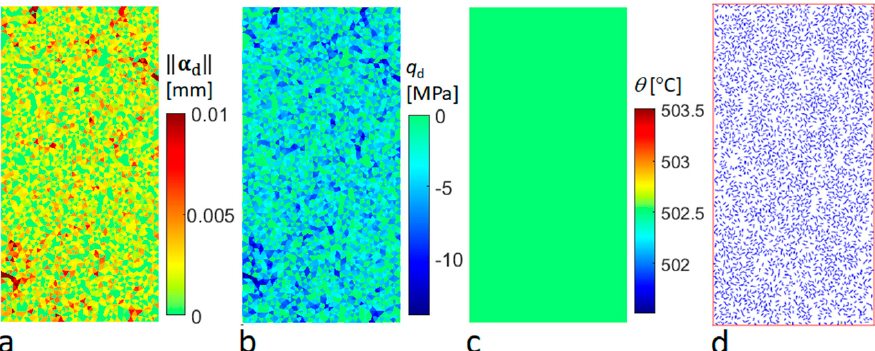
Figure 5. Simulation results for heat treatment (500 ◦ C, NumRock1): ( a ) crack opening magnitude; ( b ) stress-like softening variable; ( c ) temperature field; ( d ) thermally induced cracks (3098 cracks). When heating is continued to 502.5 ◦ C, the number of cracks increased from 2186